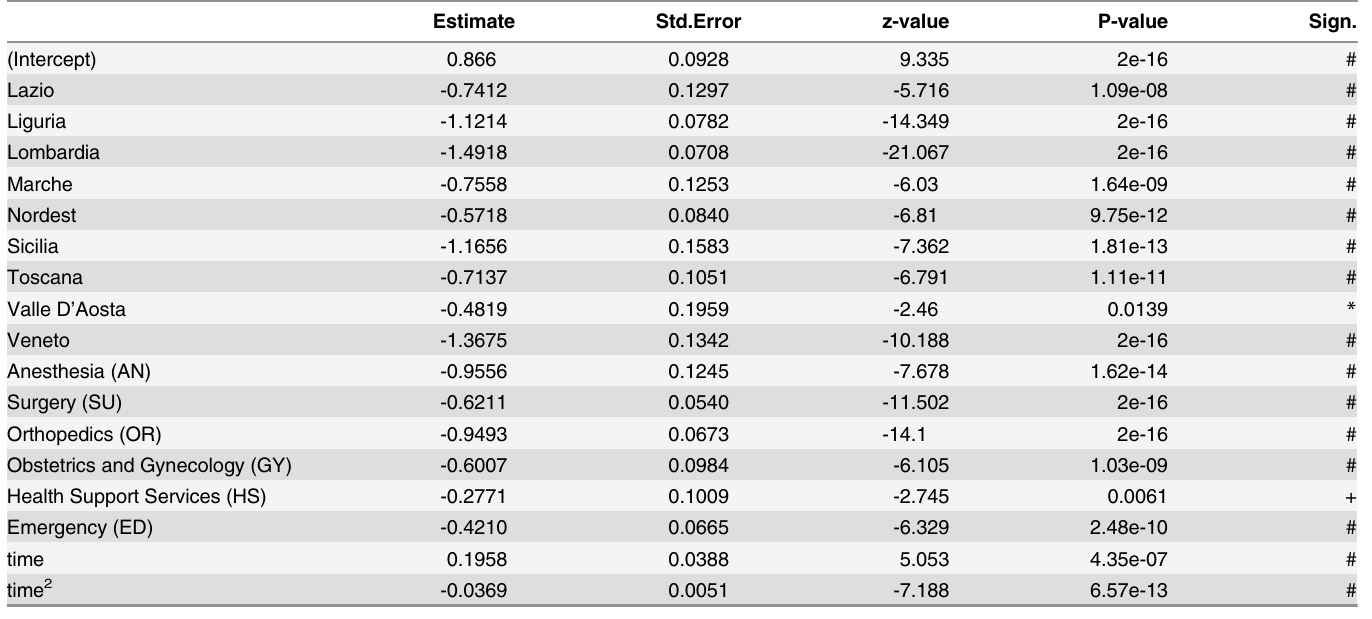
Table 18. Final model for the probability that Cost (payment) is equal to zero for claims given by injuries. Estimate Std.Error z-value P-value